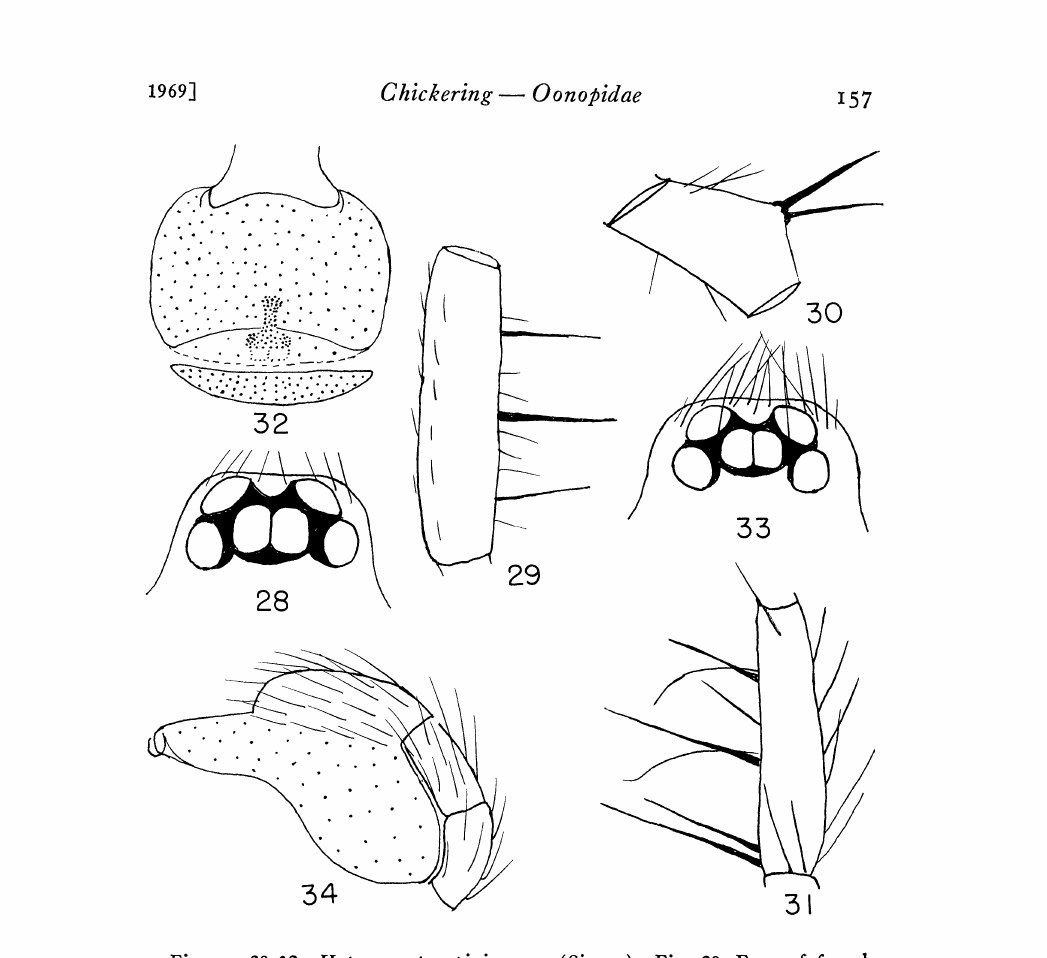
Figures 28-32. Heteroonops spinimanus (Simon). Fig. 28. Eyes of female from above. Fig. 29. Right palpal femur; retrolateral view. Fig. 30. Right palpal patella; dorsal view. Fig. 31. Right palpal tibia; dorso-prolateral view. Fig. 32. Epigynal area of female. Figures 33-34. Oonops floridanus (C. and I.). Fig. 33. Eyes of male r.om above. Fig. 34: Left palpal patella, tibia and tarsus; retrolater.al